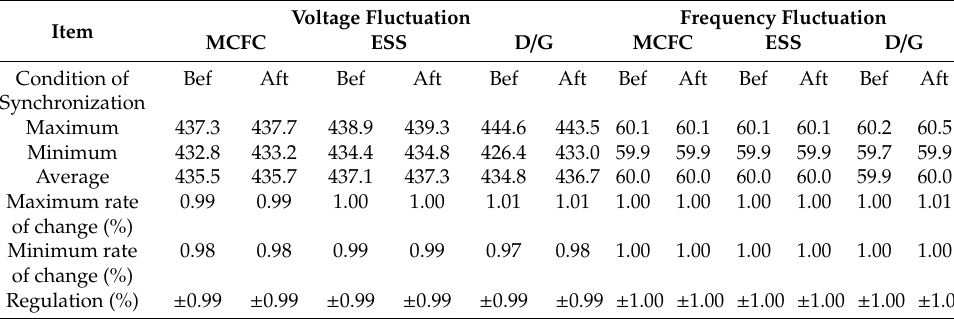
Table 17. Power data analysis before and after diesel generator